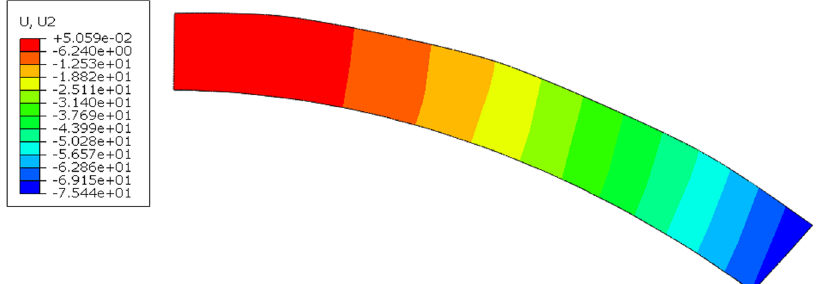
Fig. 7 The target displacement following the y-direction inputted for the fi rst case study. The beam — fi xed on the left side — exhibits a large de fl ection (76 mm) once thermally stimulated (from 40 °C to 80